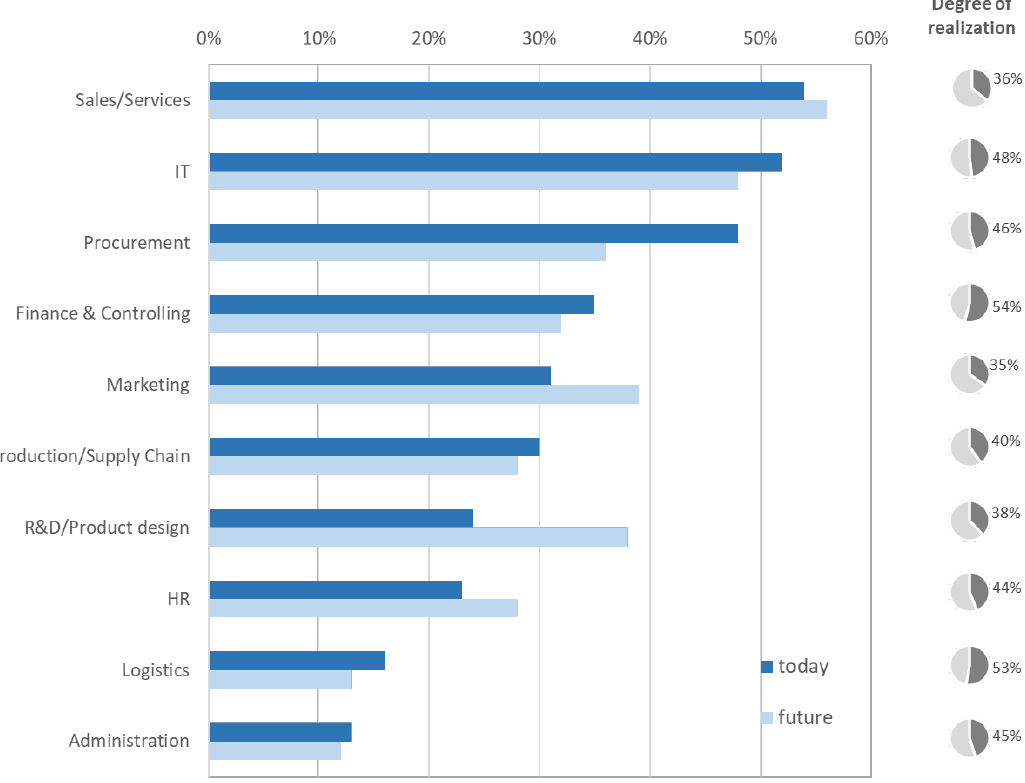
Figure 10. Activities with highest potential synergies and degree of realization. Based on [10] (p.4), modified (today = 2008/last 3 years, future = 2009–2013/next 5 years).